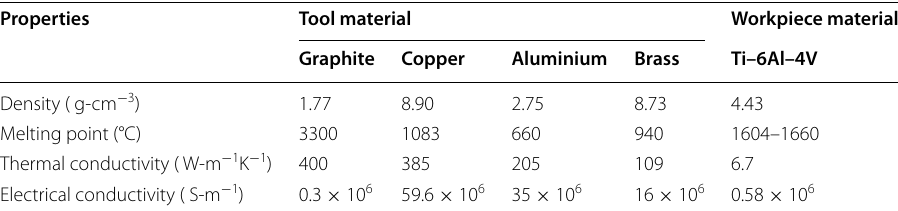
Table 2 Thermo-physical properties of work and tool materials [4] Properties Tool material